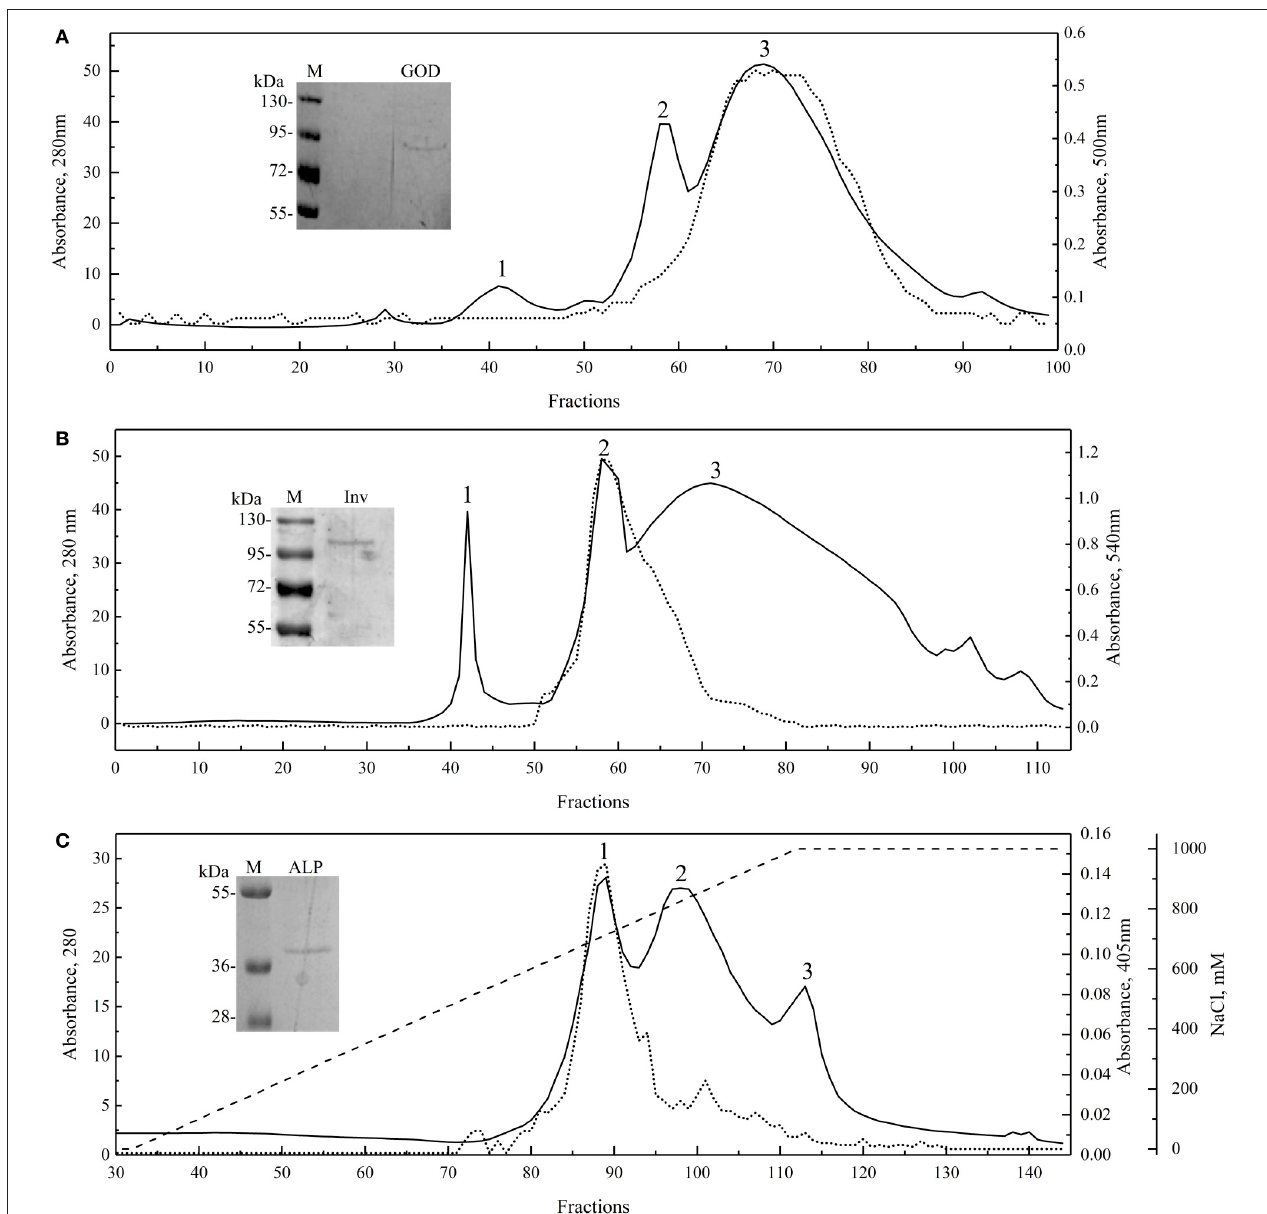
FIGURE 2 | Enzyme purification. Molecular exclusion chromatograms for GOD ( A ; Superdex 75 10/300 GL column) and Inv ( B ; Superdex 200 10/300 GL column), and anion exchange chromatogram for ALP ( C ; HiPrep 16/10 QFF column; NaCl gradient shown as discontinuous line). Runs were recorded at 280nm, and each fraction was evaluated for enzyme activity (dotted lines). SDS-PAGE of the purified and concentrated enzyme final sample are shown in each